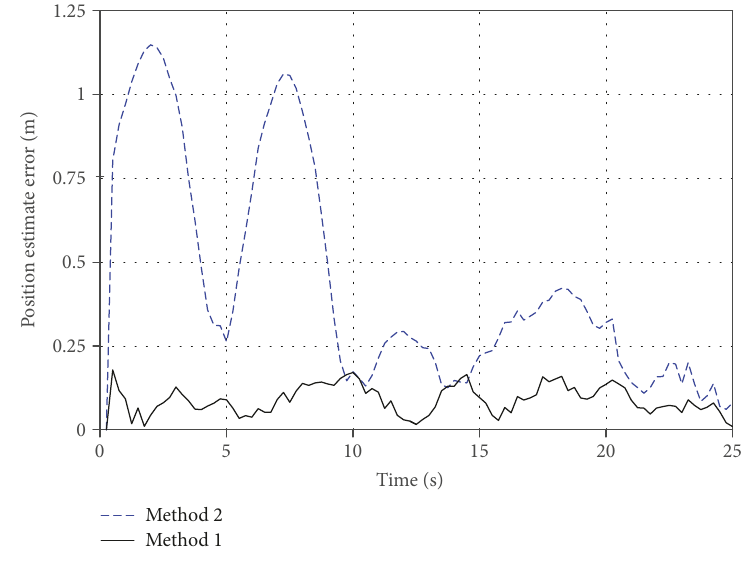
Figure 7: Position estimate error.